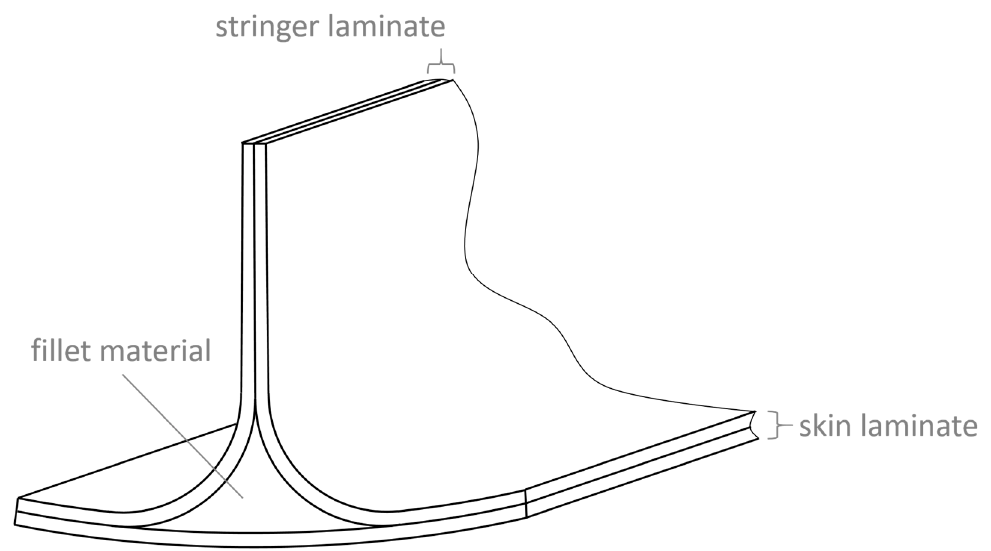
Figure 9. Stringers formed from the inner part of the skin; the final decision on specific fillet material has not been made yet.